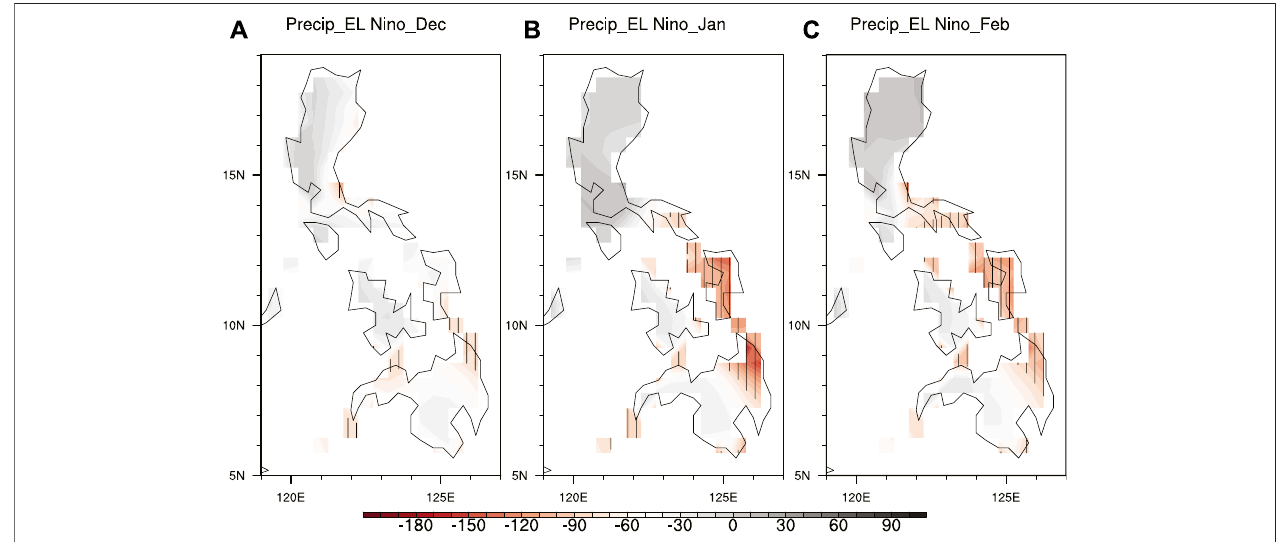
FIGURE2| Compositeprecipitationanomalies(units:mm month − 1 )derivedfromtheCRUdatasetduringElNiñomaturephasesin (A) December, (B) January,and (C) February. Shaded areas indicate the 0.05 signi fi cance